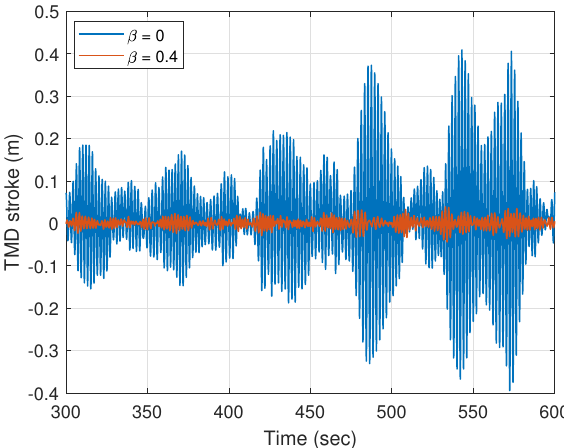
Figure 13. Tower side-to-side damper stroke.